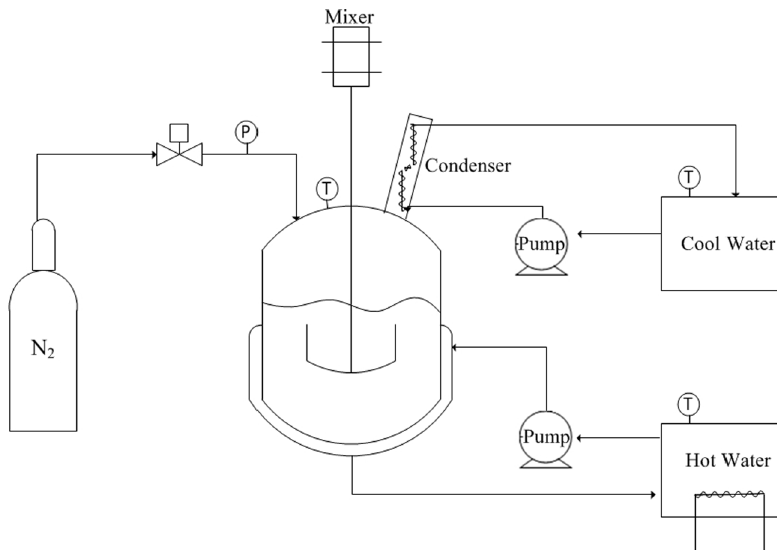
Fig. 4 The schematic of the experimental setup used for polymerization